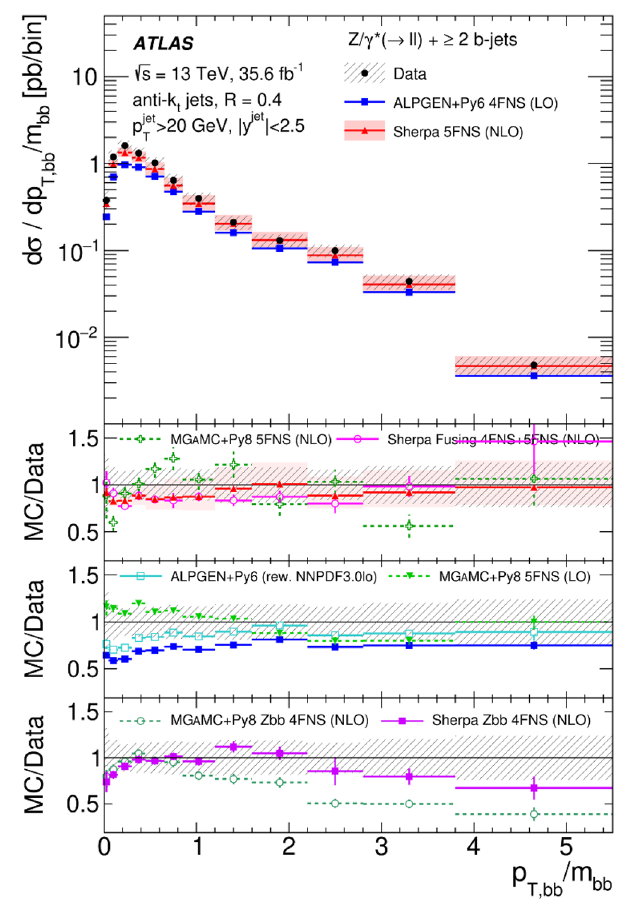
Figure 15 . Measured cross-section as a function of the p T of the di- b -jet system divided by its invariant mass ( p T ;bb =m bb ) in events with at least two b -jets. The data are compared with the predictions from Sherpa 5FNS (NLO) , Alpgen + Py6 4 FNS (LO) , Sherpa Fusing 4FNS+5FNS (NLO) , Sherpa Zbb 4FNS (NLO) , MGaMC + Py8 5FNS (LO) , MGaMC + Py8 Zbb 4FNS (NLO) and MGaMC + Py8 5FNS (NLO) . The error bars correspond to the statistical uncertainty, and the hatched bands to the statistical and systematic uncertainties of the data, added in quadrature. The red band corresponds to the statistical and theoretical uncertainties of Sherpa 5FNS (NLO) added in quadrature. Only statistical uncertainties are shown for the other